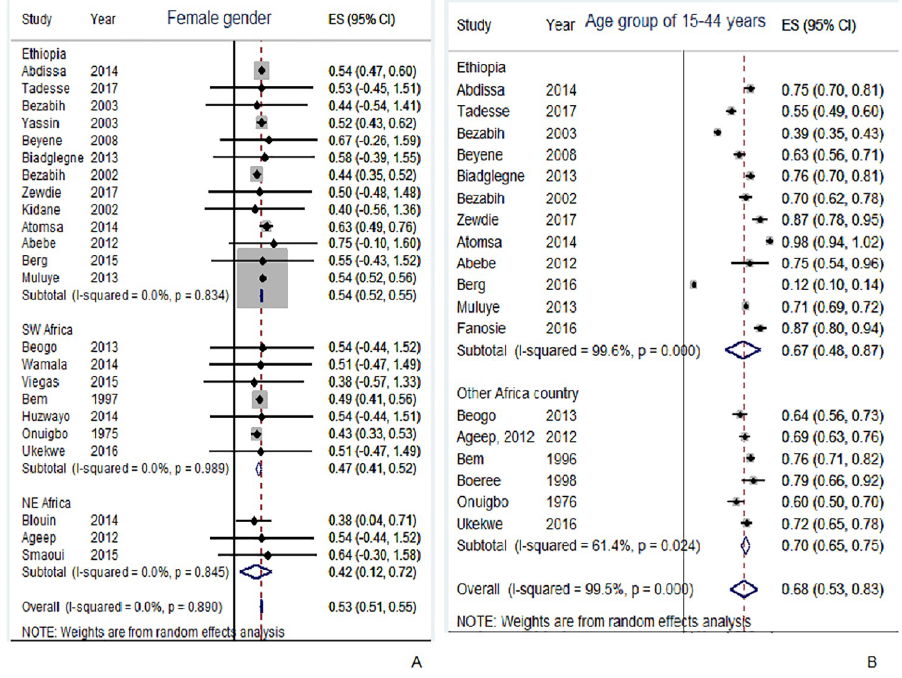
Fig 4. Proportion of female and age group of 15–44 years among TBLN cases, Africa 1970–2015.